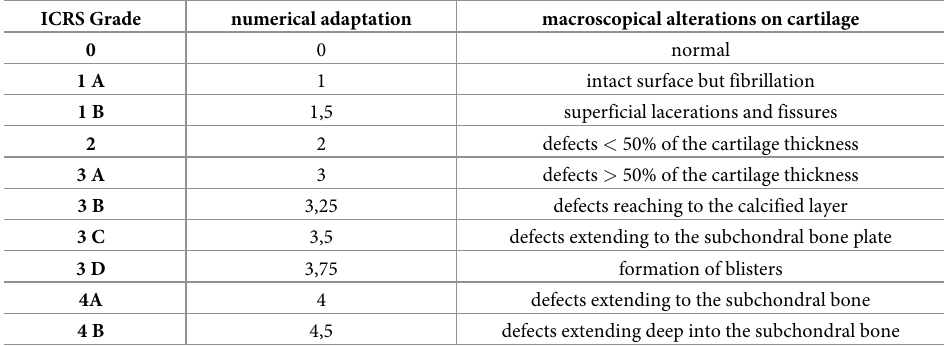
Table 1. Numerical adaption of the ICRS cartilage classification system according to Brittberg and Winalski [15]. The numerical adaptation was necessary for clearer statistical